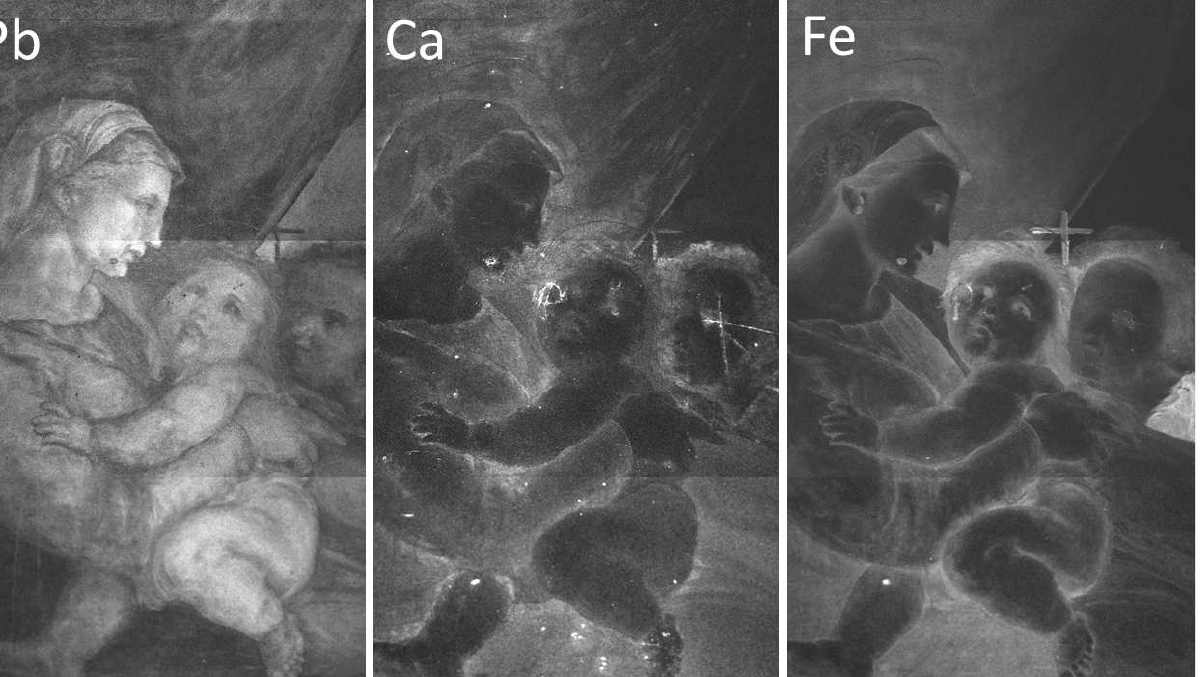
Figure 9. Microscopic images of a cross section of the Virgin’s blue mantle sample in OM ( a ) and SEM/BSE ( b ), showing a yellow-orange rounded inclusion of pigmented imprimitura in the plaster preparation. Above this, two pictorial layers—the first in azurite, the second in lapis lazuli—render the color of the blue mantle. The size of the imprimitura inclusions in the plaster is fully compatible with the enlarged radiographic details at 55× ( c ) and 220× ( d ).